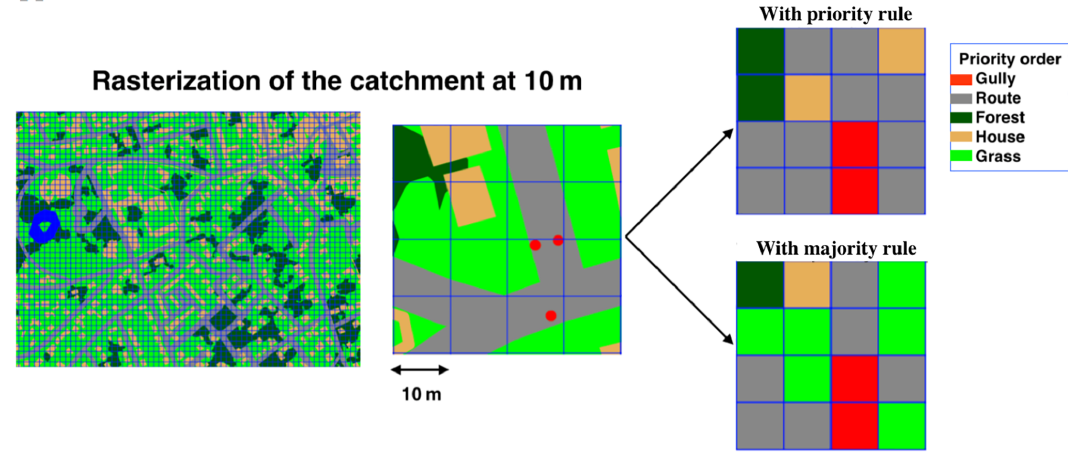
Figure 2. Two attribution methodologies are implemented in Multi-Hydro and can be used during the rasterization phase. The first one is based on a priority order defined by the user to attribute land use class, whereas the second methodology is based on a majority rule. In both methodologies, the gully class has priority, to ensure the connection between the surface and the drainage modules.